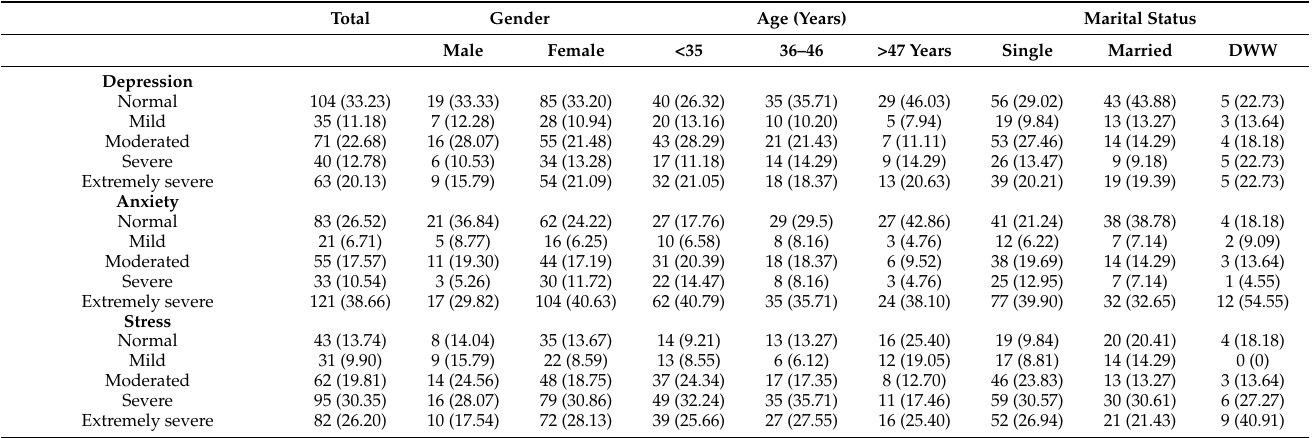
Table 3. Distribution of teachers with different symptomatology (mild, moderate, severe, and extremely severe) according to gender, age, and marital status.